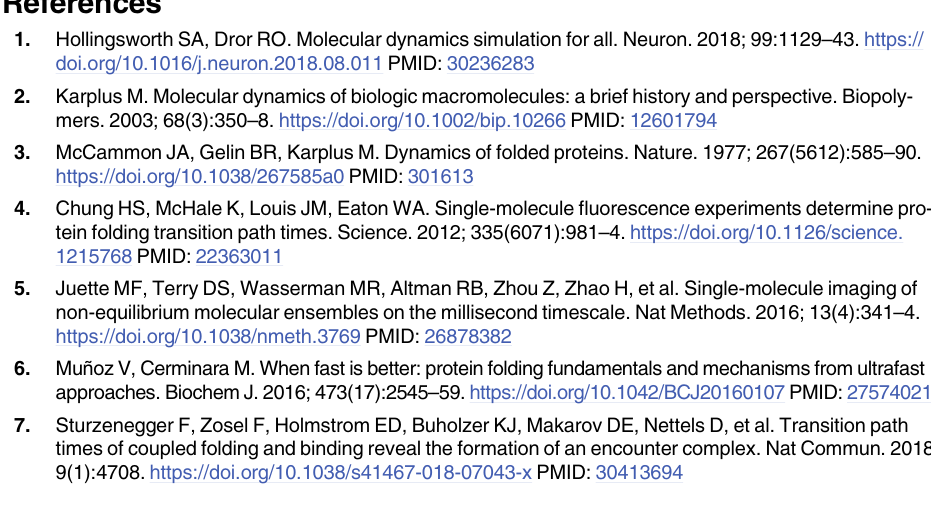
S2 Table. Parameters calculated from explicit solvent simulations to correlate free energy barriers and